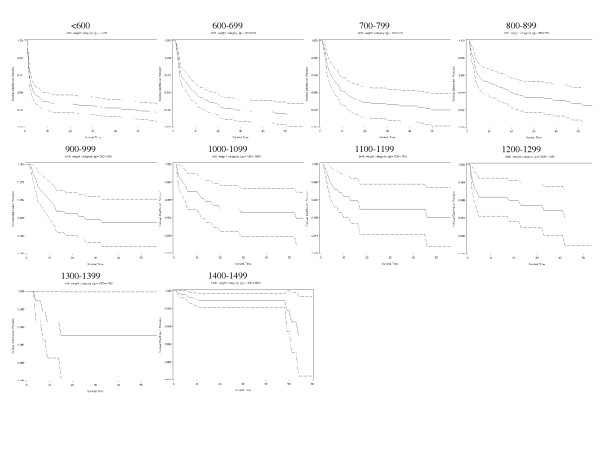
Actuarial survival curves by birth weight category.